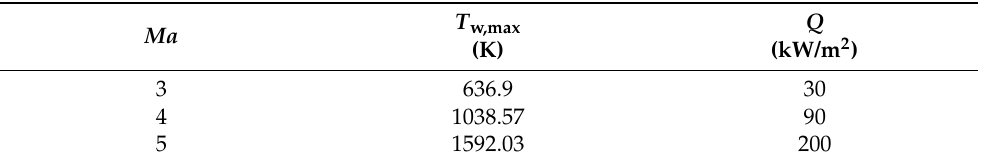
Table 2. Heat dissipation capacity ( Q ) of the low-temperature region with the highest wall tempera- ture ( T w,max ) as